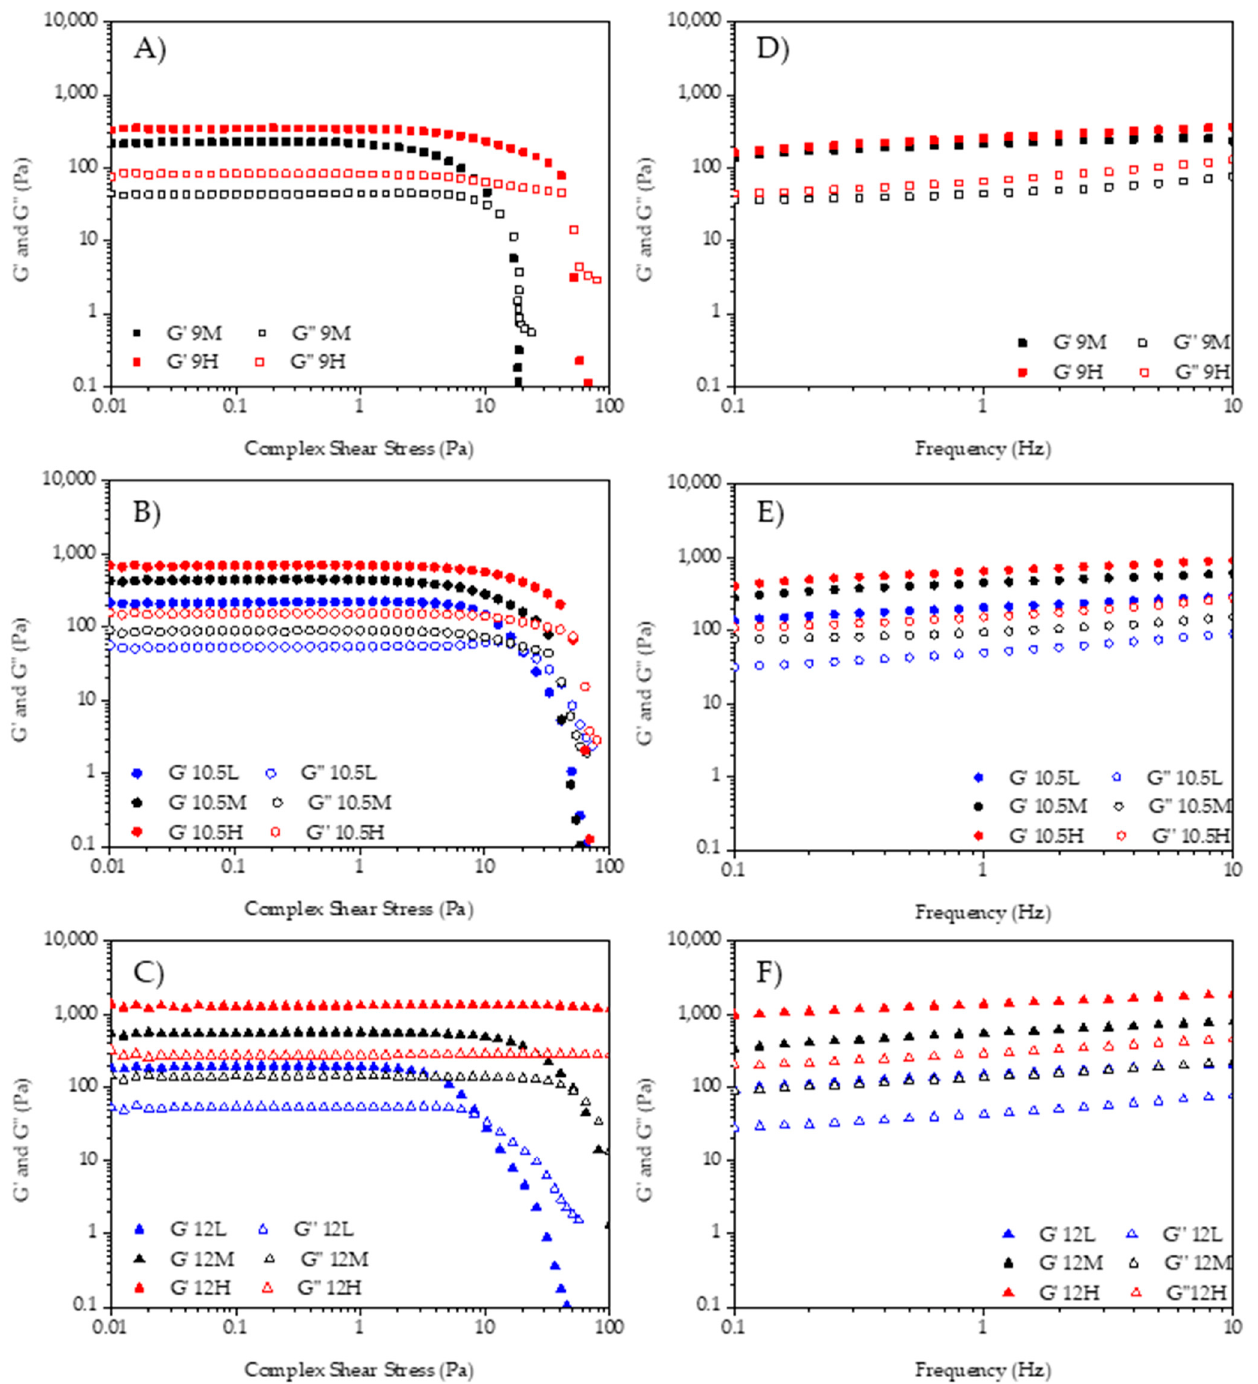
Figure 2. Rheological behavior of the emulsions. Left: amplitude sweeps; Right: frequency sweeps. ( A , D ) 9M and 9H; ( B , E ) 10.5L, 10.5M, and 10.5H; ( C , F ) 12L, 12M, and 12H.